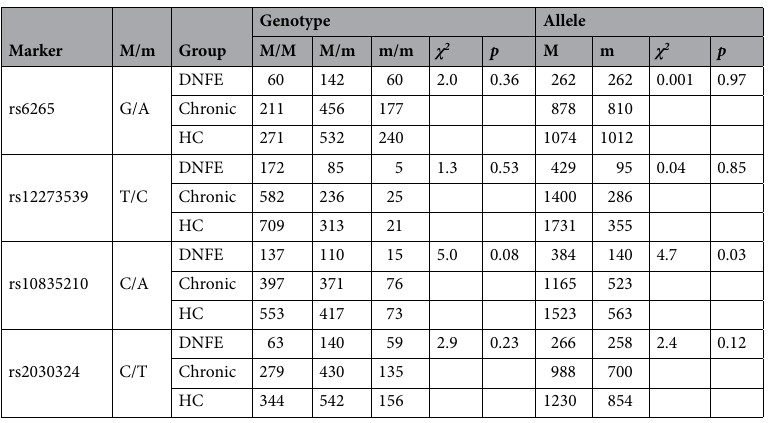
Table 2. Genotypic and allelic distributions for SNPs in the BDNF gene between SZ patients and HCs. Abbreviations: m minor allele, M major allele.